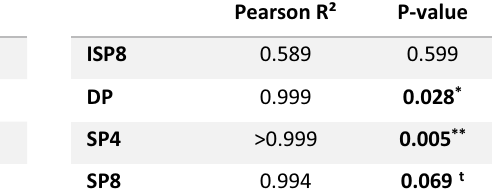
Correla(cid:143)on coefficient between EZH2 and H3K27me3 fluorescence intensity